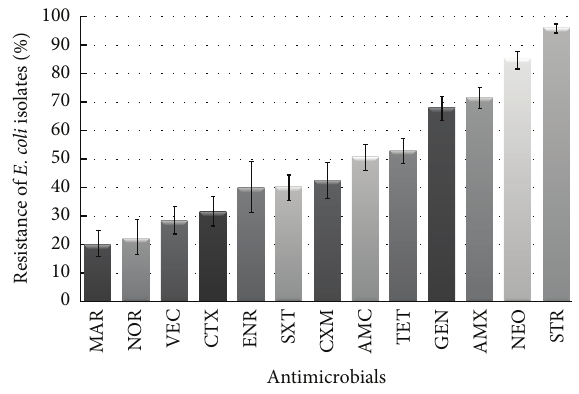
Figure 1: Antimicrobial resistance of E. coli isolates recovered from diseased dogs and cats in Poland between January 2007 and December 2013. AMC: amoxicillin/clavulanic acid, AMX: amoxicillin, CTX: cefotaxime, VEC: cefovecin, CXM: cefuroxime, ENR: enrofloxacin, GEN: gentamicin, MAR: marbofloxacin, NEO: neomycin, NOR: norfloxacin, STR: streptomycin, SXT: sulfame- thoxazole/trimethoprim, and TET: tetracycline.